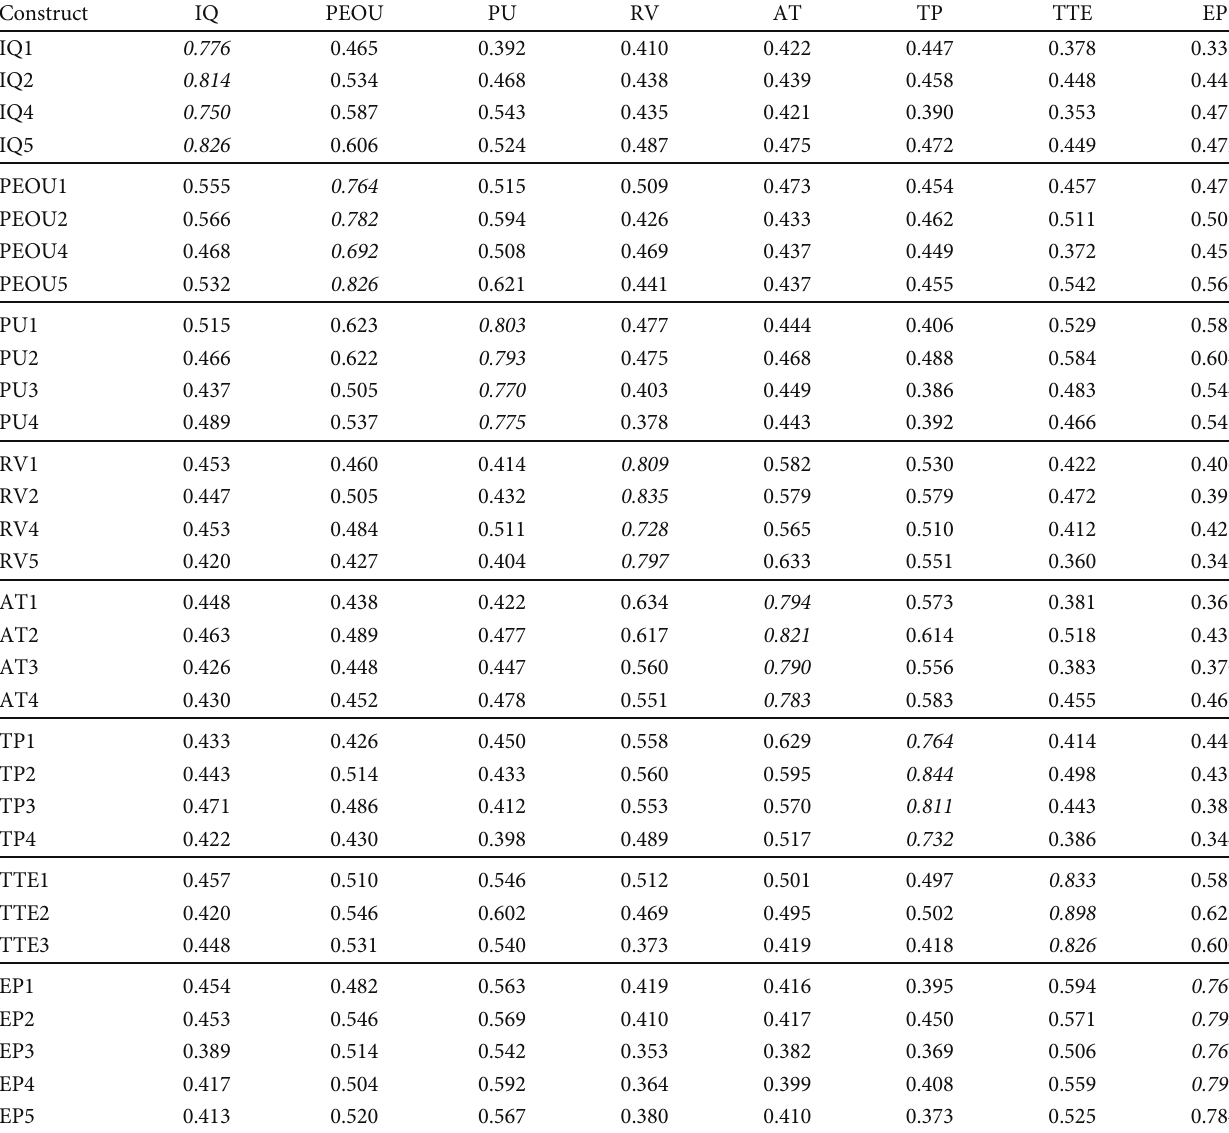
Table 6: Cross loading